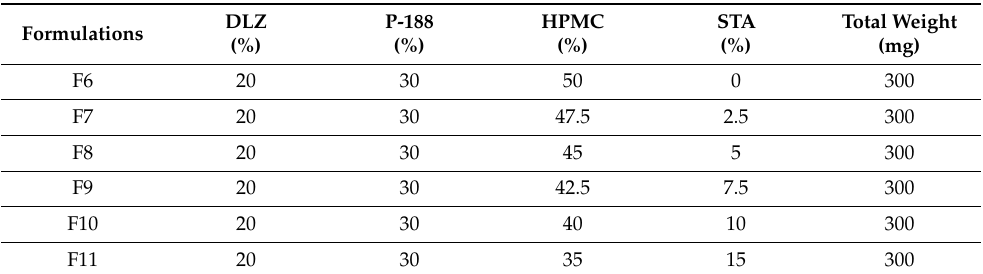
Table 2. Controlled release polymer matrices containing various drug to polymer percentages with the addition of HPMC and STA.